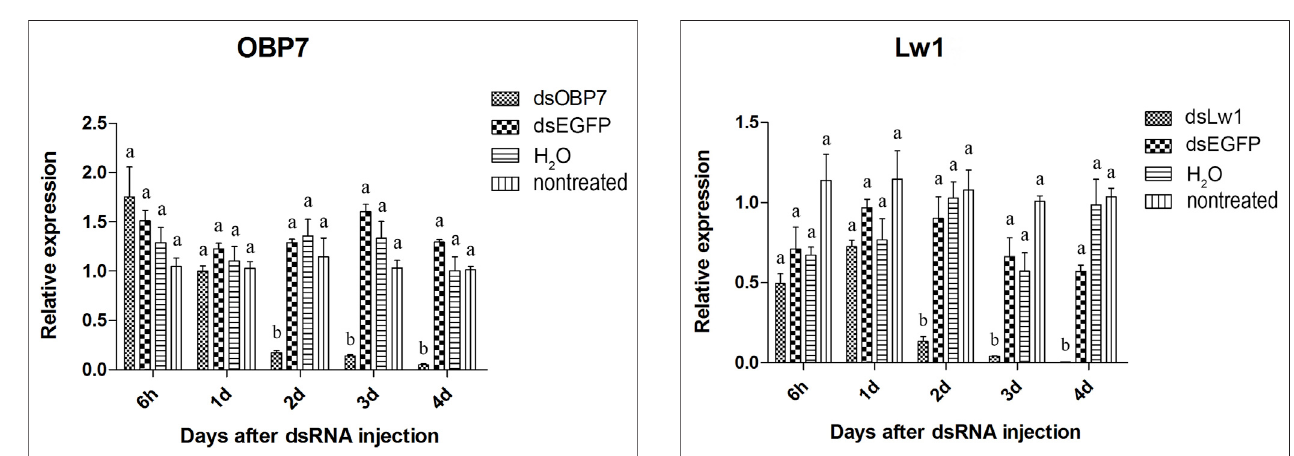
FIGURE 2 | Relative expression of OBP7 in EAB adults after dsRNA injection. Relative expression of OBP7 by RT-qPCR assay was evaluated 6h, 1,2,3and4 daysafterinjecting3 µgdsRNA. TEF-1 α wasusedasareference gene for normalization. Means ± SE (n = 4) are shown. Statistical analyses were performed using ANOVA/LSD method at p < 0.05 for comparison among treatments. Statistical differences are shown by different letters between different treatments at the same time point.